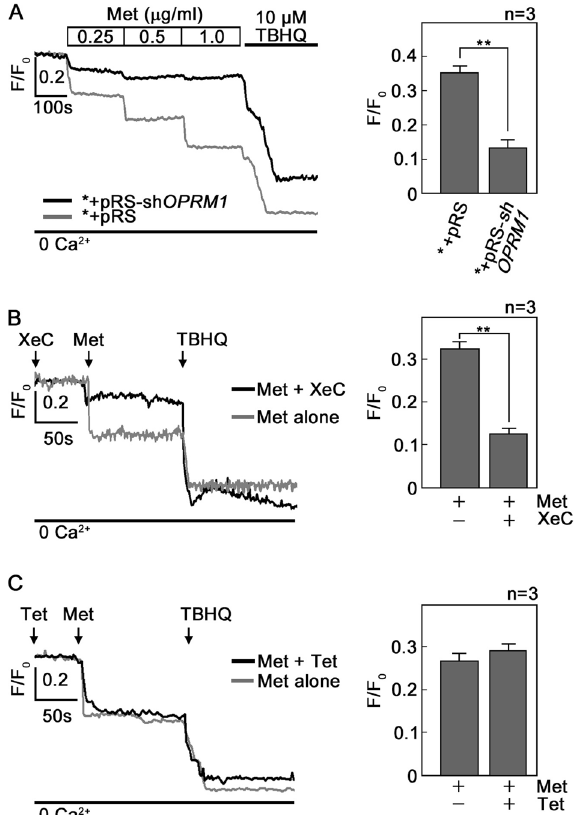
Figure 3. d,l-Methadone induces IP3R-mediated ER Ca 2+ release that is inhibited by OPRM1 loss. ( A ) d,l-methadone induces ER Ca 2+ release that is inhibited in OPRM1-depleted cells. *+pRS and *+pRS- sh OPRM1 cells were loaded with Mag-Fluo-4 AM for 30 min then treated with increasing concentrations of d,l-methadone (0.25, 0.5 and 1 μg/ml) then analyzed for ER Ca 2+ release by Ca 2+ imaging. The chart on the right panel shows ER Ca 2+ release upon treatment of cells with 0.5 μg/ml d,l-methadone. ( B ) and ( C ). d,l- Methadone-evoked ER Ca 2+ release occurs via the IP3R channel. Thirty min after loading with Mag-Fluo-4 AM, *+pRS cells were treated with xestospongin C (XeC, in B ) or tetracaine (Tet in C ) for 10 min. ER Ca 2+ release upon d,l-methadone addition was then measured every 2 s. The right panels show ER Ca 2+ release upon treatment with d,l-methadone with or without prior treatment with XeC ( B ) or Tet ( C ). Representative data from one of three independent experiments (n = 3) showing similar results. Ca 2+ response after TBHQ addition indicates that cells were viable during the assay. Values are means ± SEM from three independent experiments (n = 3). ** p <